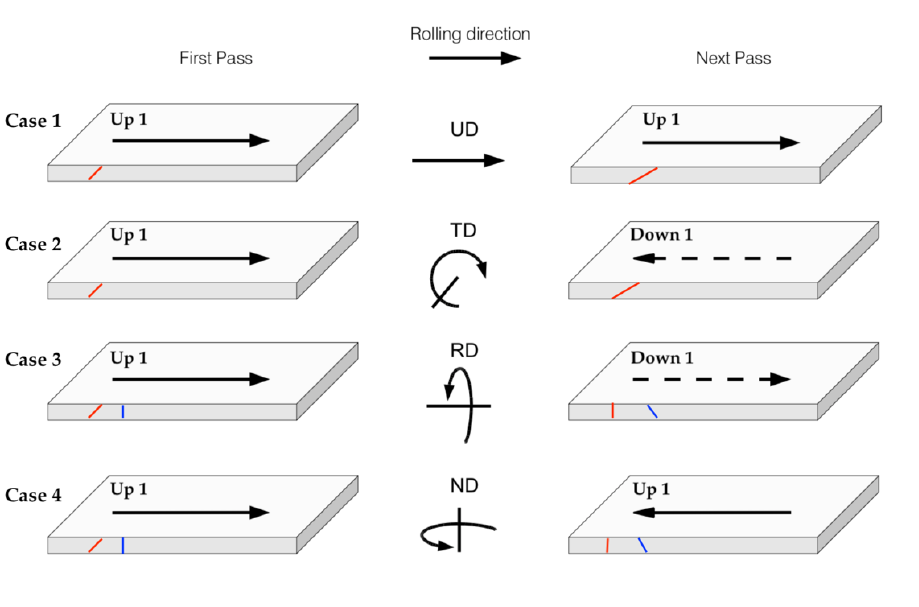
Figure 4. Asymmetric rolling routes (adapted from [25], with permissions from authors, 2020). Up1 and Down1 are the surfaces of the